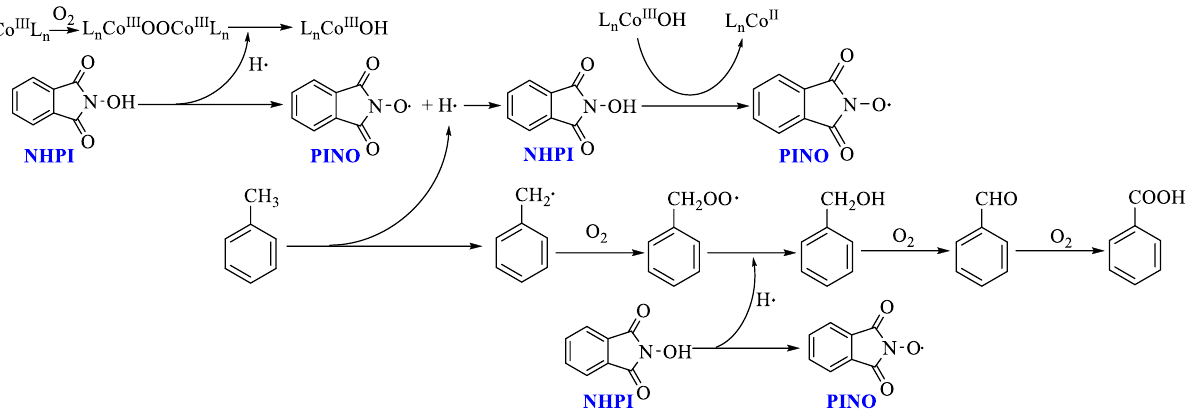
Figure 12. The proposed mechanism of selective oxidation of toluene by Co-ZIF catalyst.